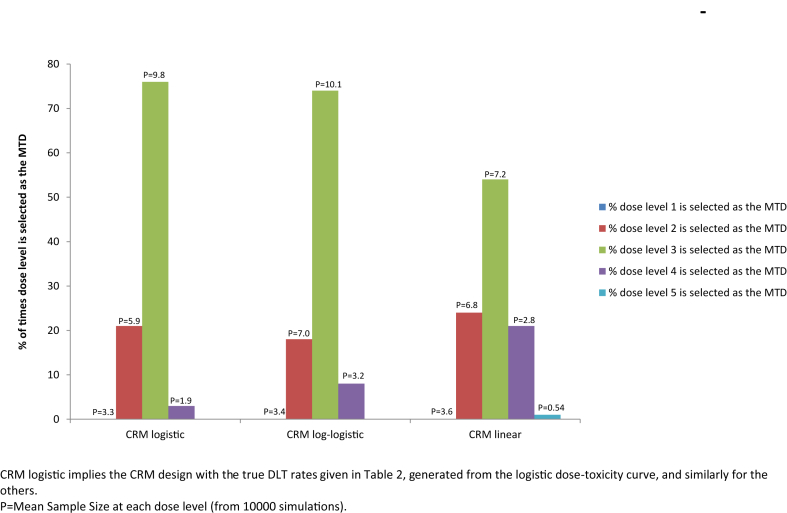
The figure depicts the percentage of times that the CRM design selects each dose level as the MTD for the true DLT rates given in Table 2, generated from the three dose-toxicity curves. These percentages are from simulations and the results are shown in Table 3, Table 4, Table 5.